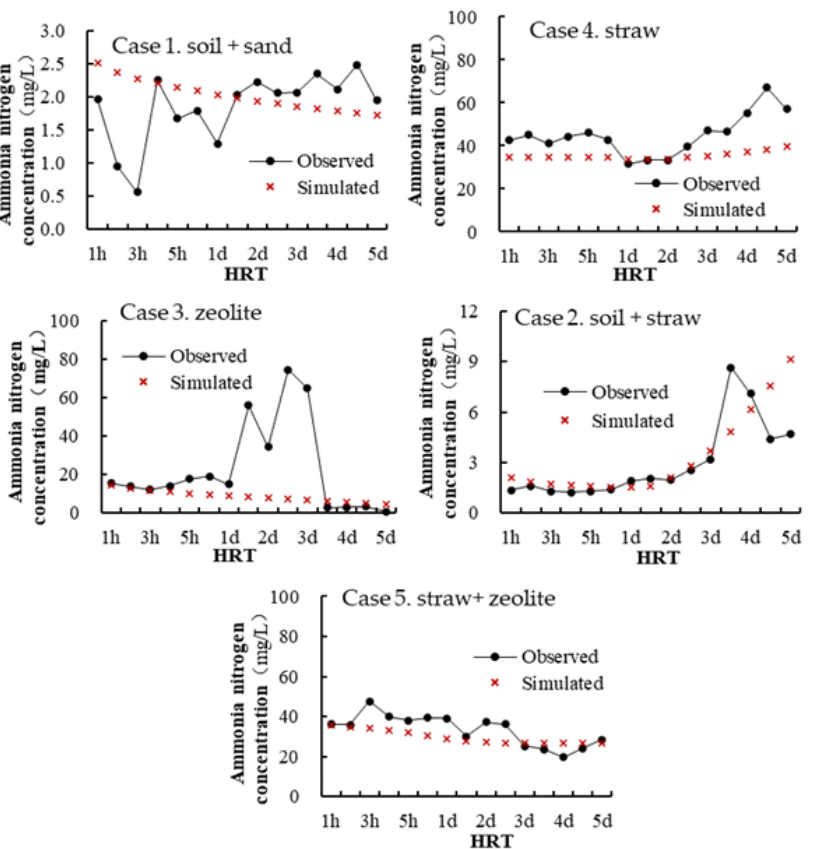
Figure 3. Comparisons of observed and simulated NH 4+ -N concentrations. To deeply evaluate model performance of water simulation, statistical parameters of correlation coefficient ( R ) and relative error ( RE ) were selected and shown in Table 4. For the case of zeolite, the NH 4+ -N concentrations were sharply increased when the HRT was 1 d and the large concentrations lasted until 3 d. Then, the NH 4 + -N concentrations were sharply decreased. The mechanism of this process is not clear and it may be an er- ror of measurement, so the influence of this period is ignored in the statistical parame- ters. Totally speaking, the simulation results may be accepted whose relative errors were within 25%.